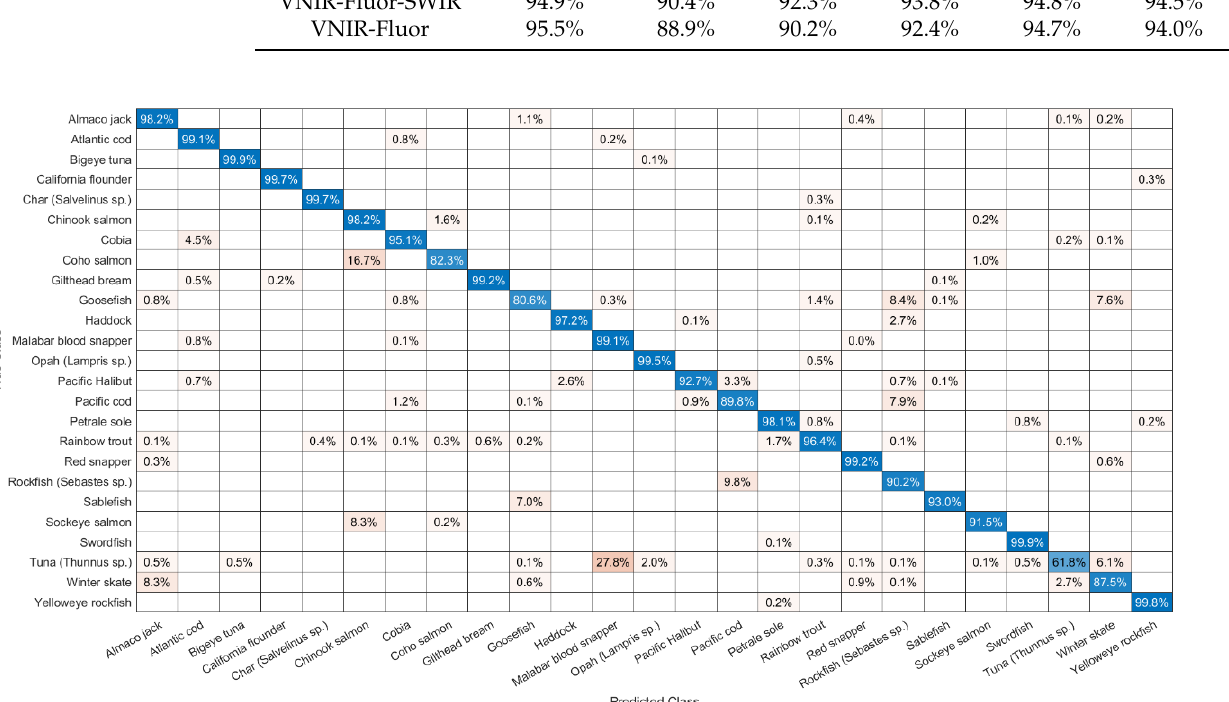
Figure 14. Confusion matrix for the fusion of all three spectral modes with k = 7 selected wavelengths (overall classification accuracy = 94.5%).